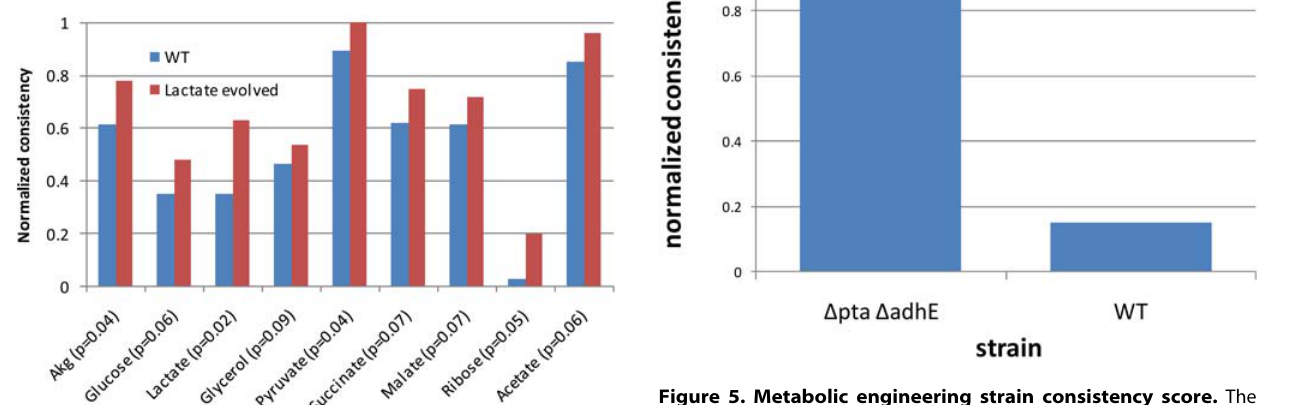
Figure 5. Metabolic engineering strain consistency score. The normalized consistency score for an E. coli strain designed to produce lactate indicate that the D pta D adhE strain has a metabolic gene expression state consistent with the simultaneous production of lactate and growth when compared with the wild-type. This higher normalized consistency score indicates that the gene expression data from the double deletion strain is more consistent with the metabolic engineering objective than the wild-type strain, in accordance with experimental measurements.